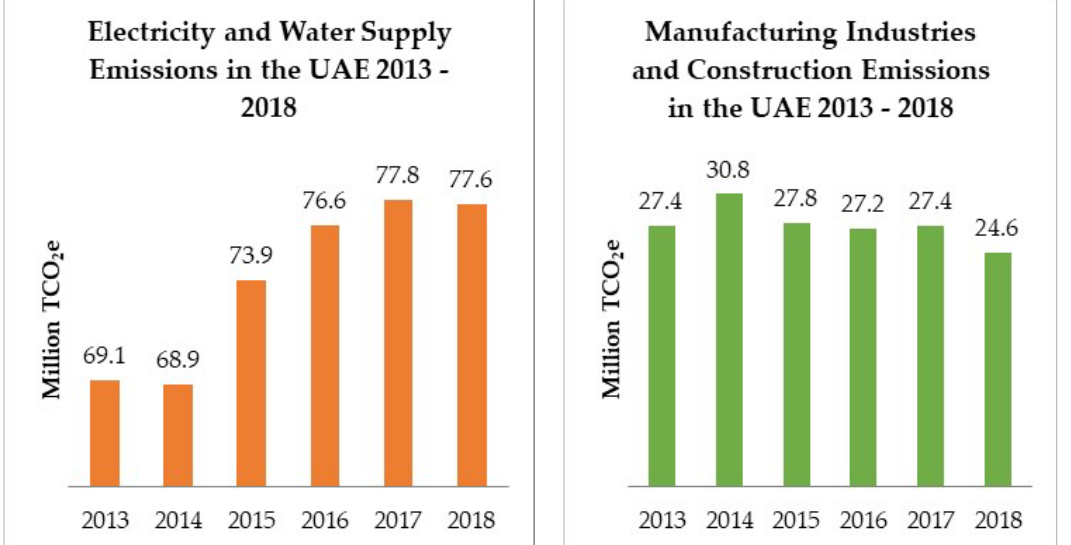
Figure 4. Carbon emissions in the UAE electricity and water supply sector vs. the construction sector between 2013 and 2018. Source: [8].